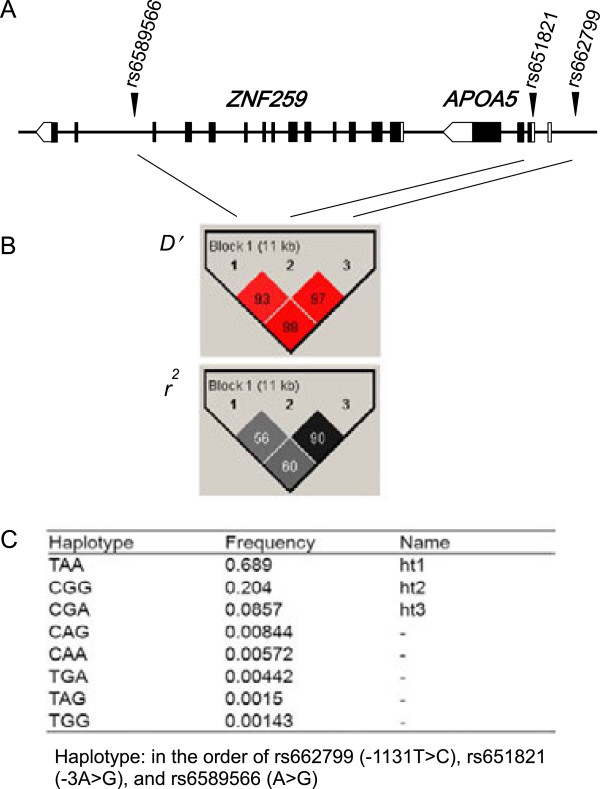
Genetic location, linkage disequilibrium (LD), and haplotypes of single-nucleotide polymorphisms (SNPs). (A) The SNPs rs662799 and rs651821 are respectively located in the promoter and 5′ untranslated regions of APOA5 that has 4 exons, whereas SNP rs6589566 is found in intron 12 of ZNF259 that has 14 exons. (B) LD structure of three SNPs: D′ and r2. (C) Haplotype sequence and frequency: haplotypes with frequencies over 5% were named as ht1, ht2, and ht3.